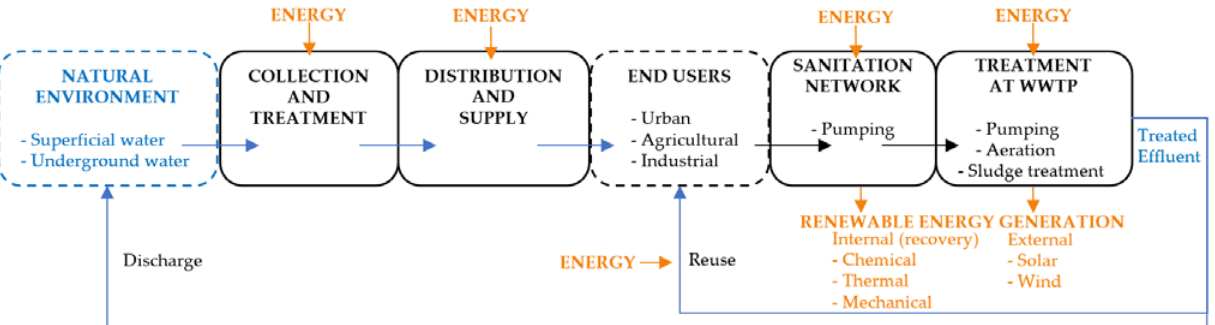
Figure 1. Water cycle diagram.